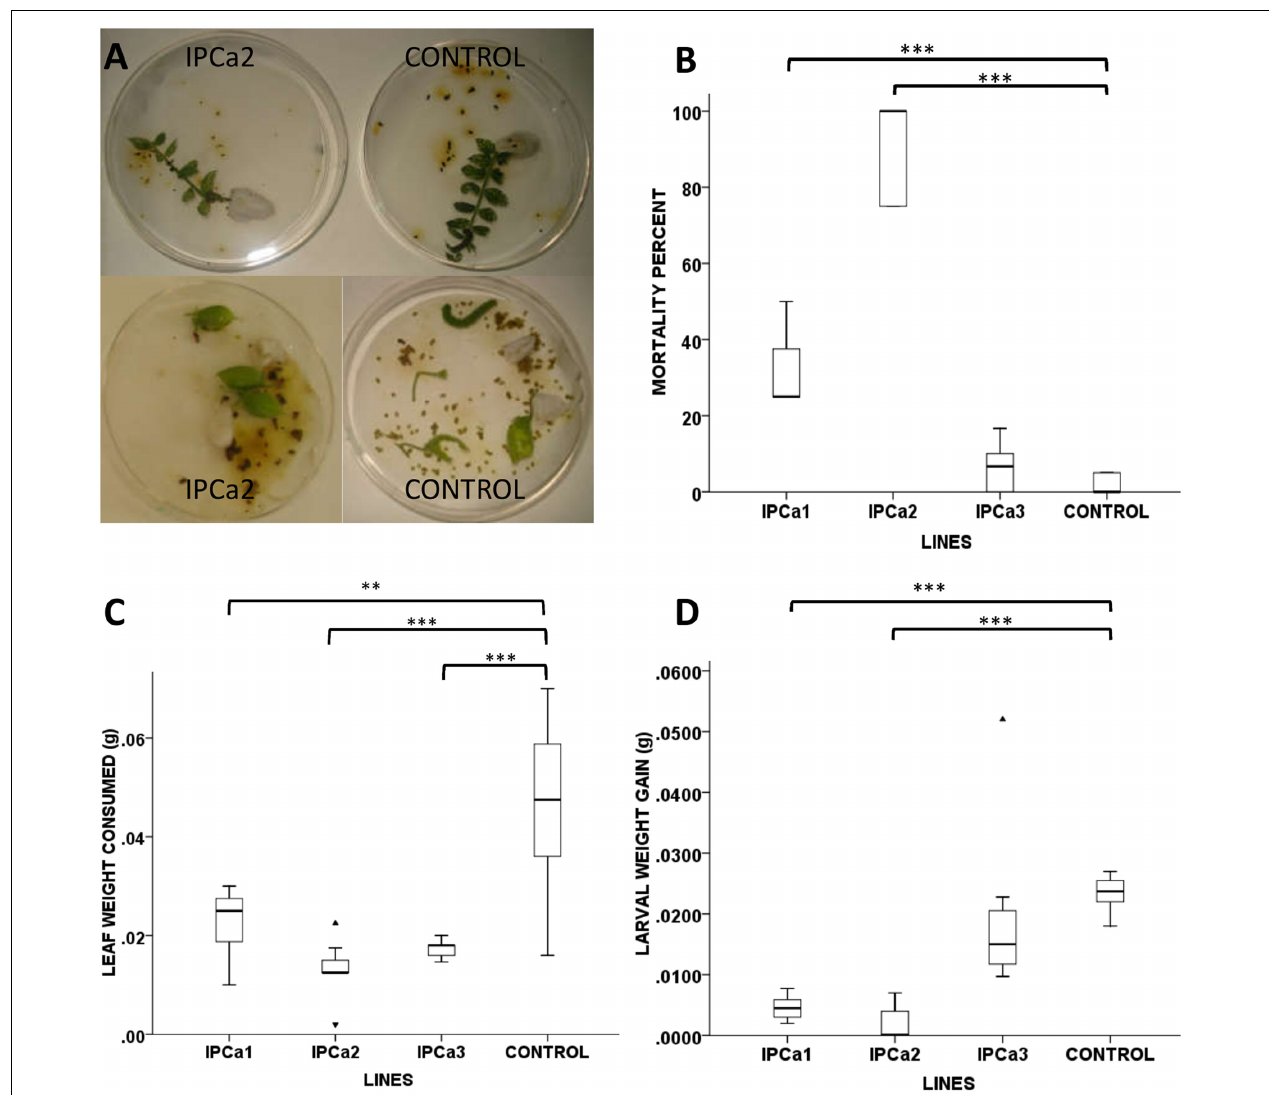
FIGURE 2 | Insect bioassay of transgenic chickpea lines. (A) Detached leaf assay (no choice condition) of transgenic chickpea line (IPCa2) and non-transgenic DCP 92-3 (CONTROL). (B) Box plot depicting significant higher percent mortality of neonates in transgenic chickpea line (IPCa1 and 2) compared to non-transgenic DCP92-3 (CONTROL). (C) Box plot depicting significantly lower average leaf consumed by neonates in all transgenic chickpea lines (IPCa1, 2, and 3) compared to non-transgenic DCP92-3 (CONTROL) ( F = 12.037, P < 0.01). (D) Box plot depicting significant lower average weight gain of neonates in transgenic chickpea line (IPCa1 and 2) compared to non-transgenic DCP92-3 (CONTROL) ( F = 13.482, P < 0.001). ∗∗ P < 0.01 and ∗∗∗ P < 0.001. (cid:78) indicate higher outlier and (cid:72) lower